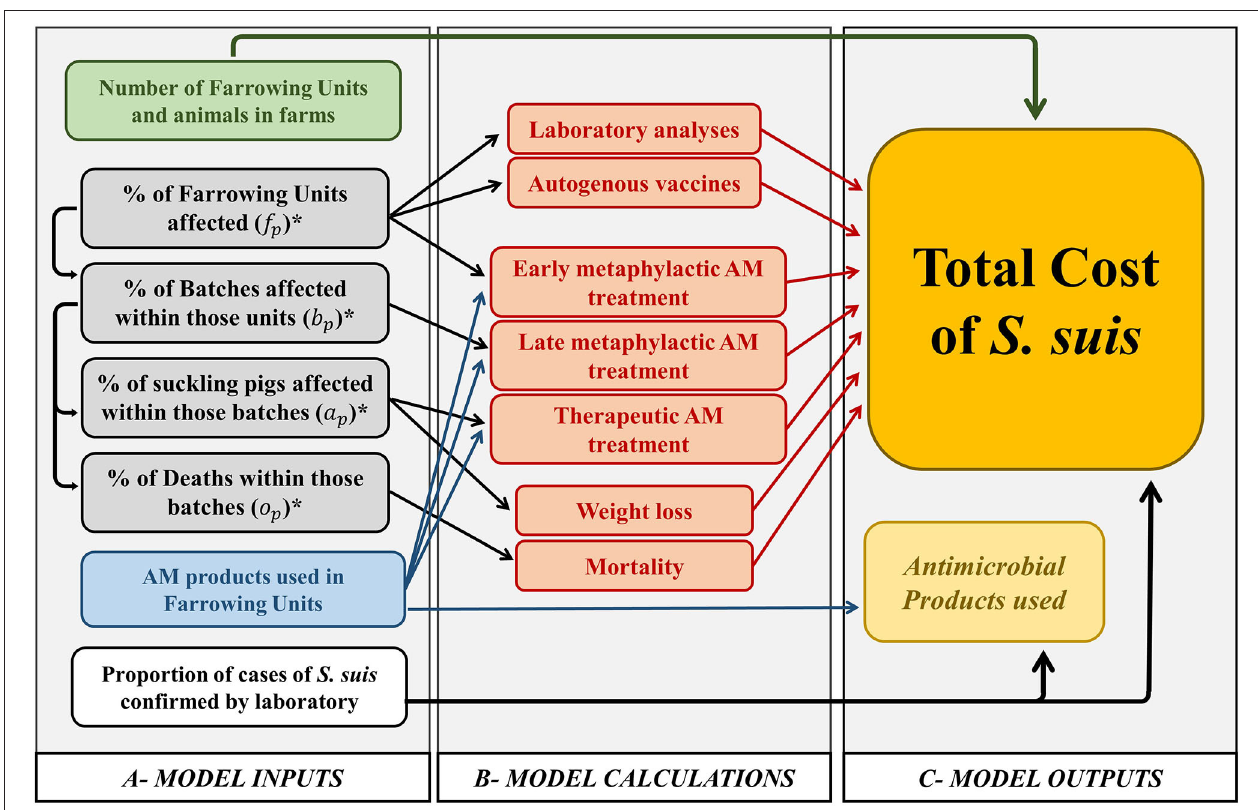
FIGURE 1 | Diagram of the quantification of costs associated with S. suis infection and antimicrobial use in farrowing units. Gray area represents data obtained from the questionnaire for veterinarians. Red area represents estimates of the different costs associated with S. suis infection. Yellow area represents the outputs of calculations. *Subindex p refers to suckling piglets (i.e., farrowing units), similar calculations were carried out for nursery pigs in weaning units (subindex n ) and fatteners in fattening units (subindex f ), which when summed result in the calculation of the total cost at the end of the production